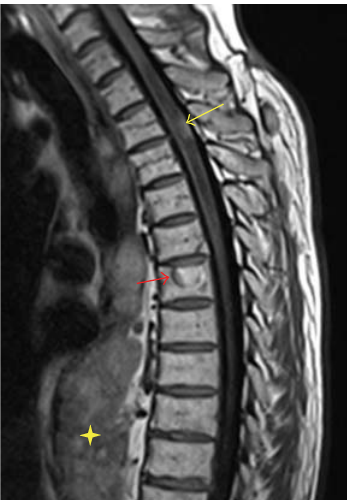
Figure 14: Sagittal T1-weighted MR image reveals an intramedul- lary hyperintense lesion in the dorsal upper thoracic cord from a melanoma metastasis (yellow arrow). There is extensive surround- ing hypointensity due to spinal cord edema. Additionally, there is a T1 hyperintense vertebral body metastatic lesion (red arrow). Large lobulated paraspinal masses are also noted (yellow star).